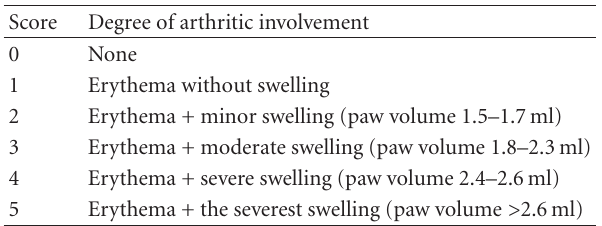
Table 1: Arthrogram score evaluation according to the degree of arthritic involvement for each